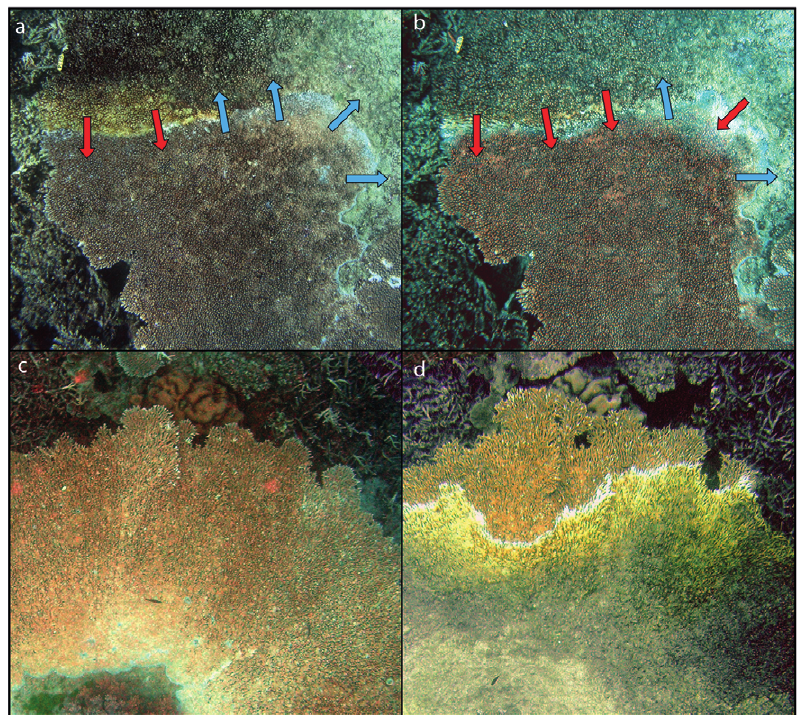
Figure 6. Temporal patterns of white syndrome lesions. Tissue degeneration (indicated by red arrows) and regeneration (indicated by blue arrows) in lesions from a) 6 th April 2004, b) 14 th April 2004, and evidence of axial growth of Acropora cytherea affected by Acroporid white syndrome in c) 6 th April 2004, d) 20 th February 2006.